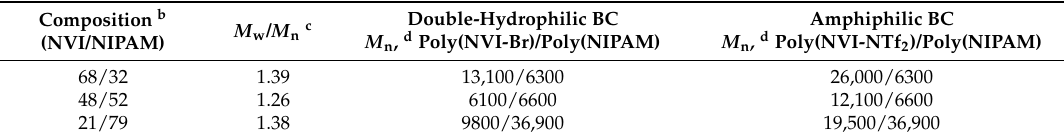
Table 1. Characterization data of double-hydrophilic and amphiphilic block copolymers (BCs) prepared by RAFT polymerization, followed by anion-exchange reaction a